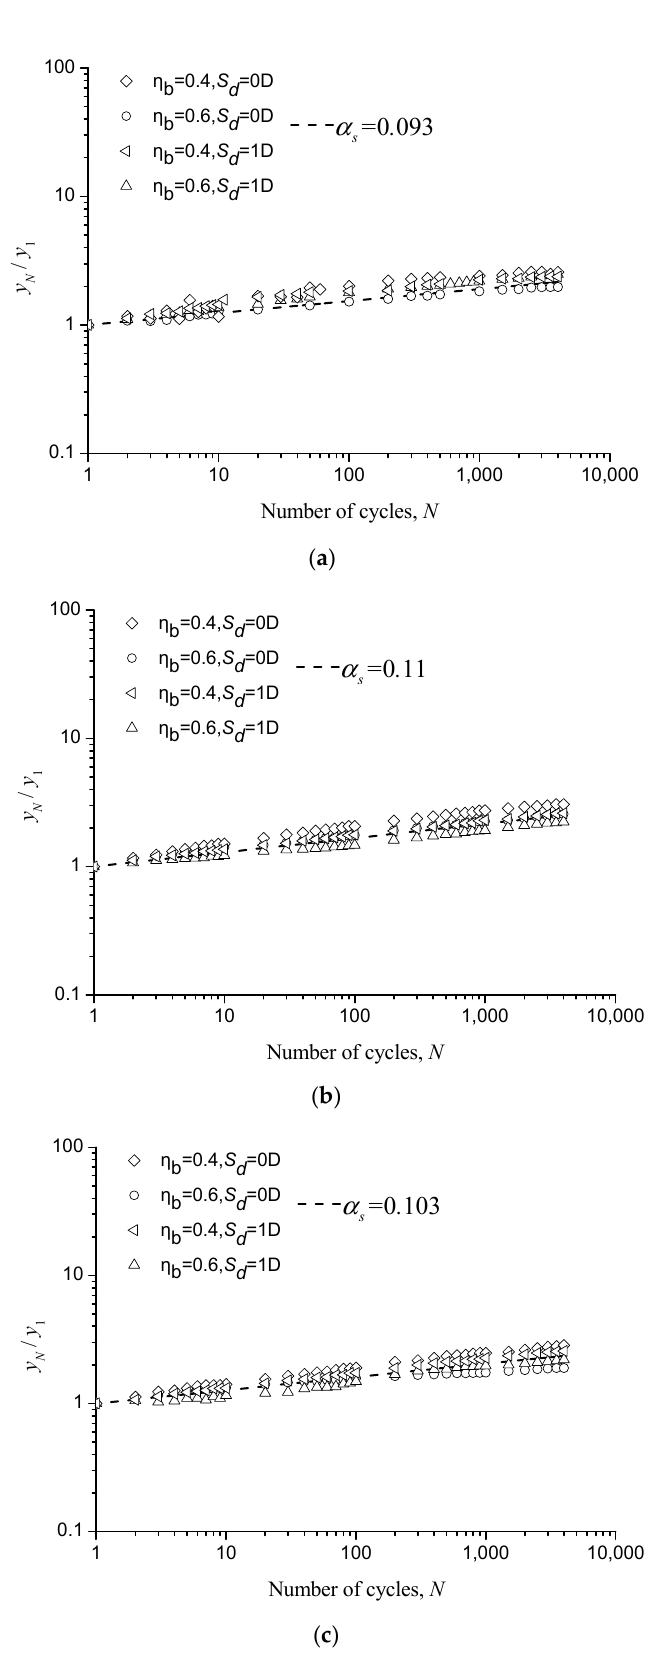
Figure 15. Nondimensional accumulated residual displacement to cycle number. ( a ) α = 0° ( b ) α = 30° ( c ) α = 45°.